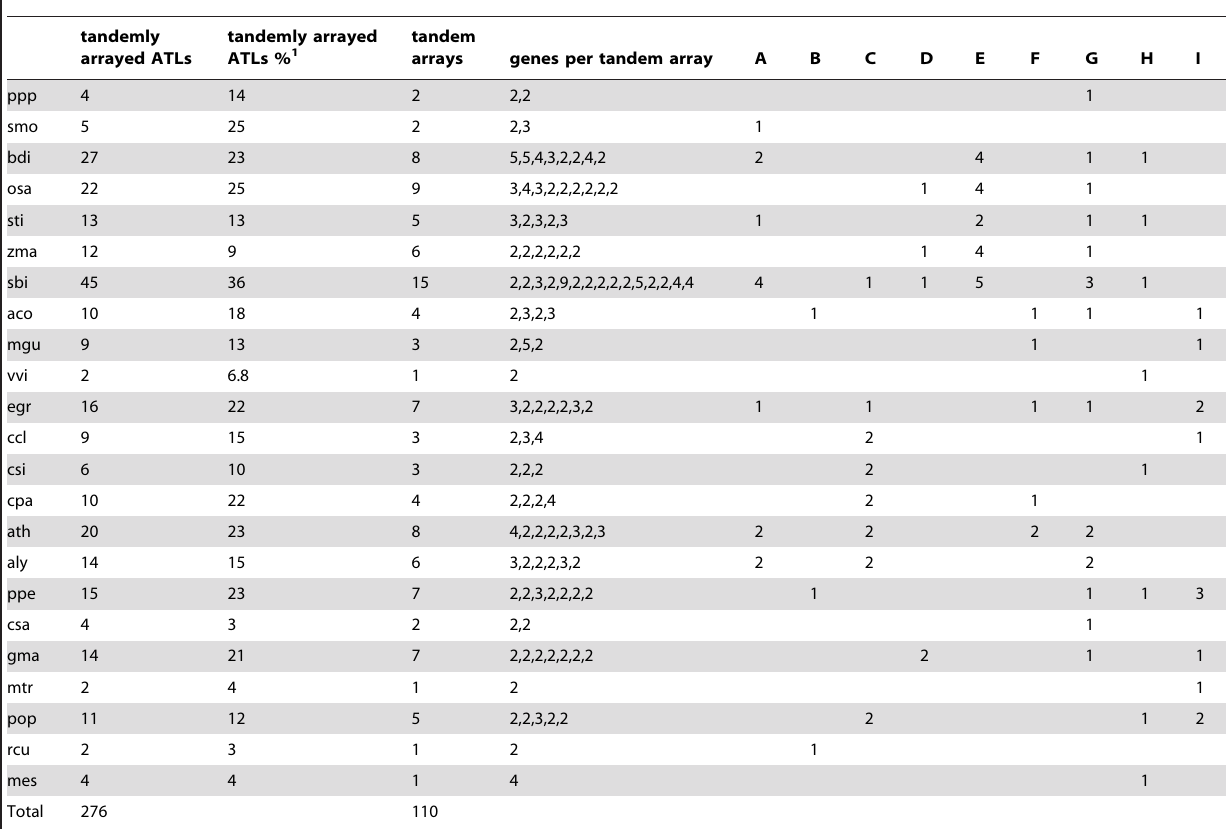
Table 2. Tandemly arrayed ATLs.